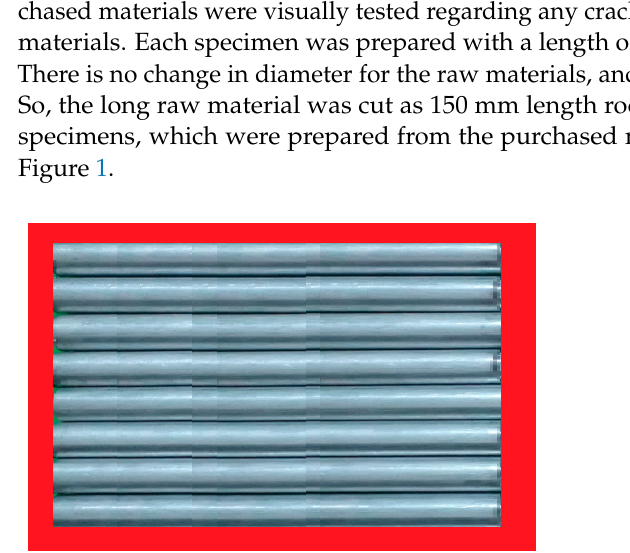
Figure 1. Raw materials of Aluminum alloy Al7075 rods in multiple